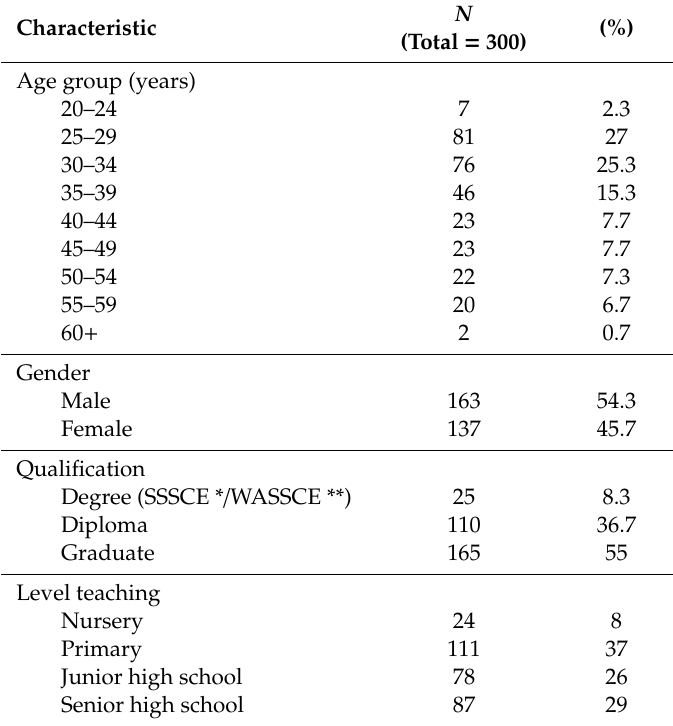
Table 1. Characteristics of the study